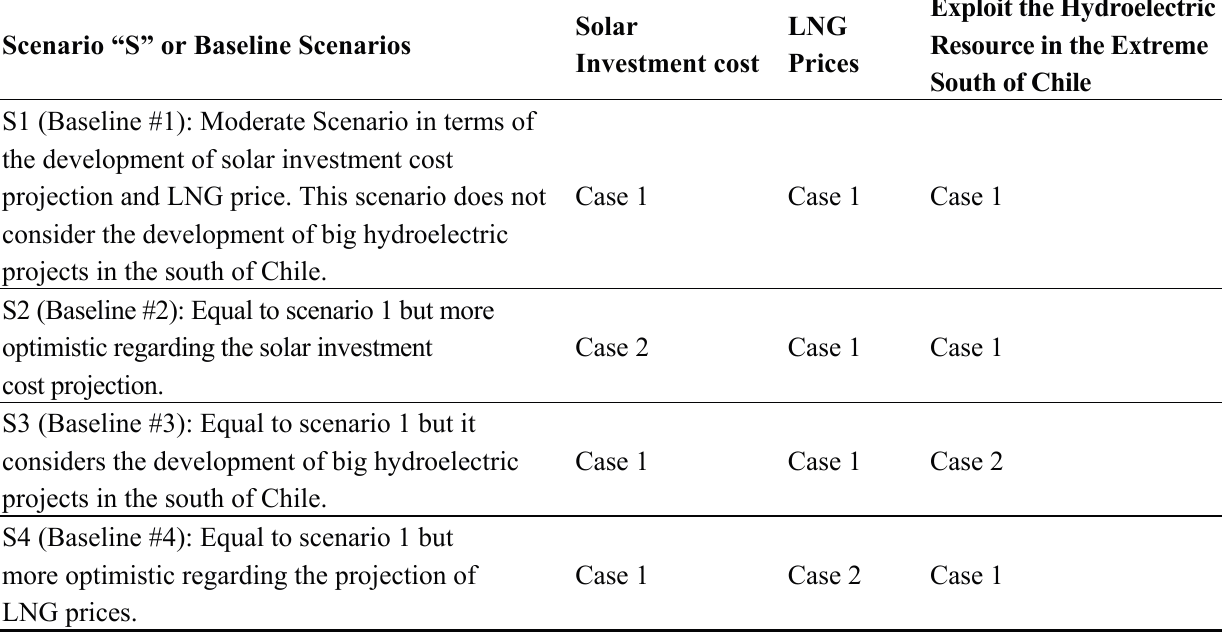
Table 2. Evaluated scenarios built from the sources of uncertainties. These scenarios are called baseline